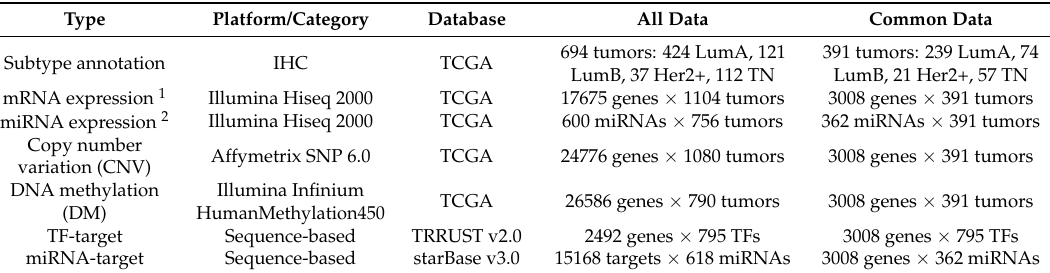
Table 1. Multi-dimensional data used to build the